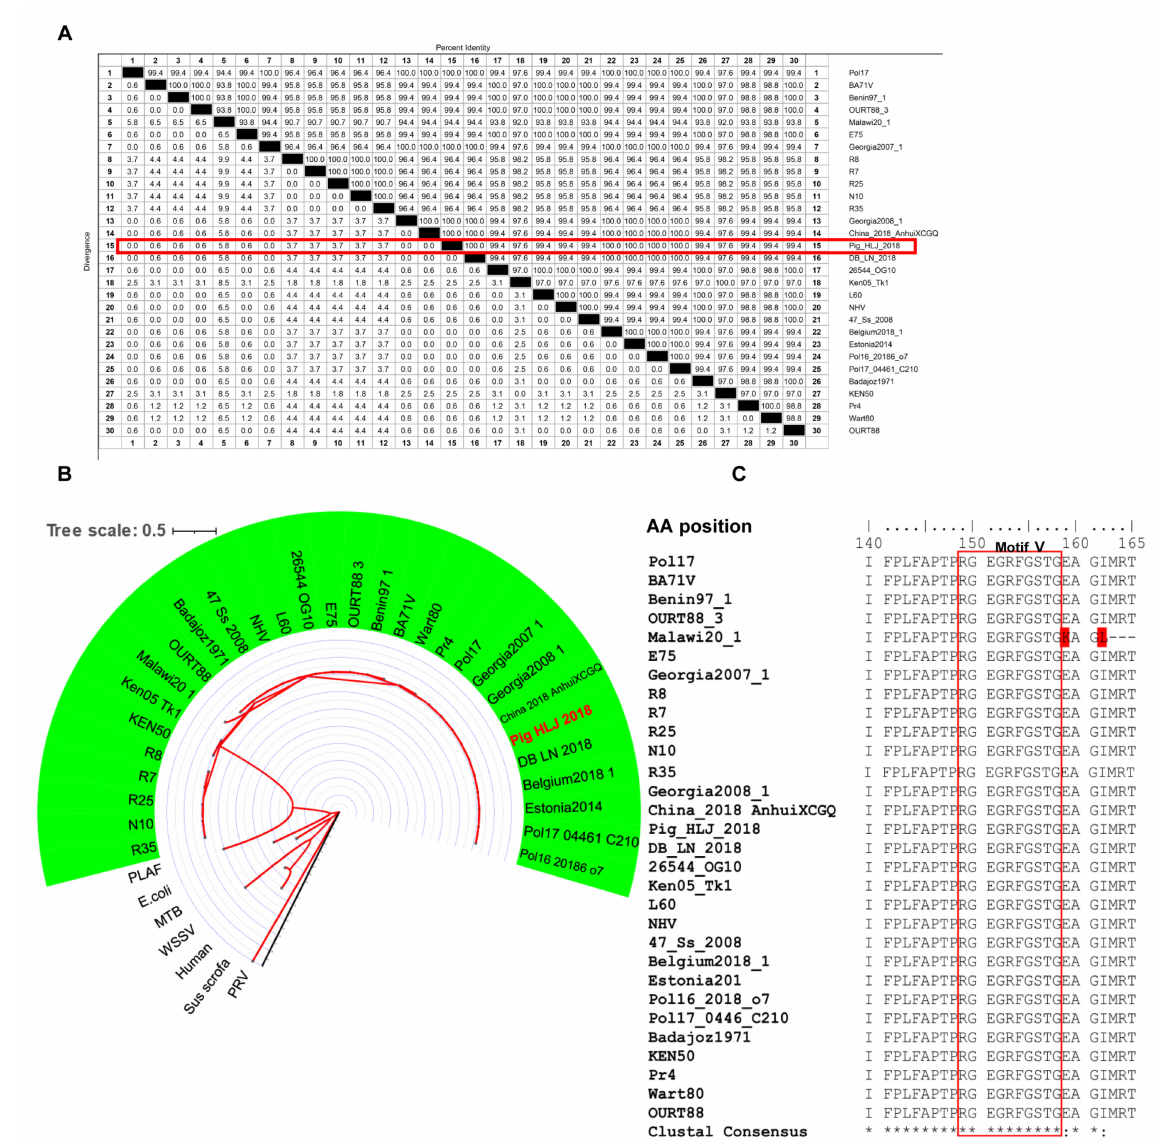
Figure 4. Homology analysis of the ASFV dUTPase (E165R) amino acid sequence. ( A ) Alignment of E165R amino acid sequences among different ASFV strains. The similarity between the amino acid sequence of E165R of Pig_HLJ_2018 and other ASFV strains is highlighted in red. ( B ) E165R genetic evolution analysis (maximum likelihood method (ML)). Human, Homo sapiens; PRV, Pseudorabies virus; PLAF, Plasmodium falciparum; WSSV, White spot syndrome virus; E. coli , Escherichia coli ; MTB, Mycobacterium tuberculosis. The ASFV strain is shaded in green and sequence ID details are shown in Table S3. Branch lengths are highlighted in red. ( C ) Homology analysis of epitopes in E165R recognized by 8F9 mAb, residues in motif V are highlighted in red and differential amino acids are marked in red